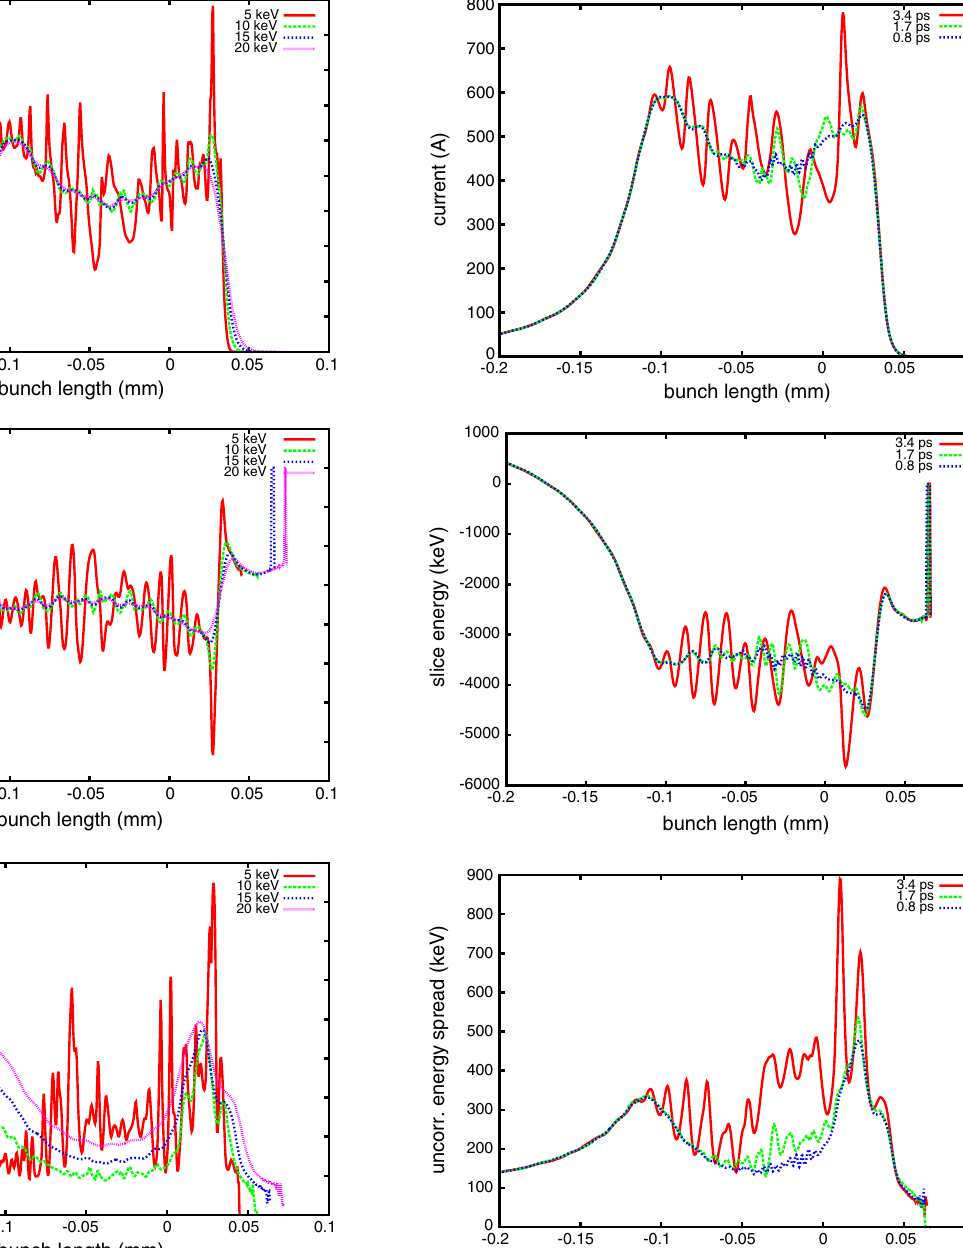
FIG. 8. Final electron beam current profiles (top) and longi- tudinal phase space distributions (bottom) with different initial uncorrelated energy spread.